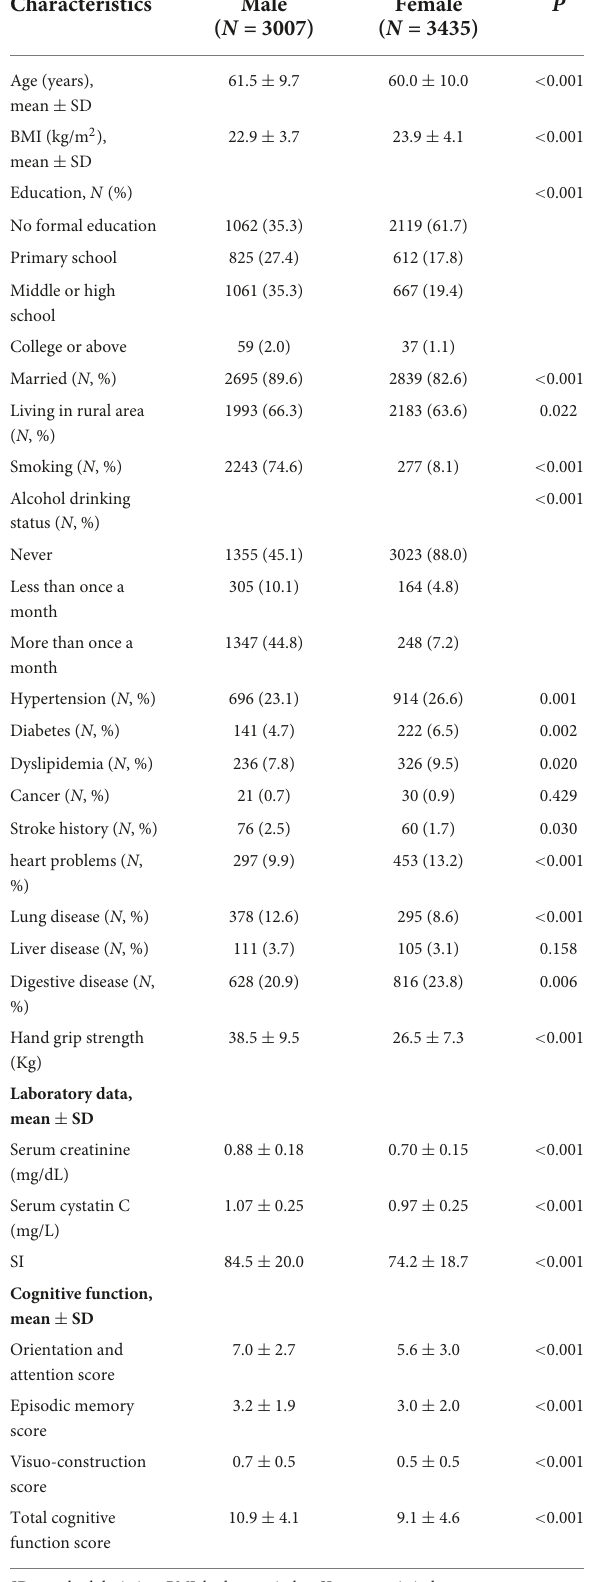
TABLE 1 Demographic data of the study participants. Characteristics